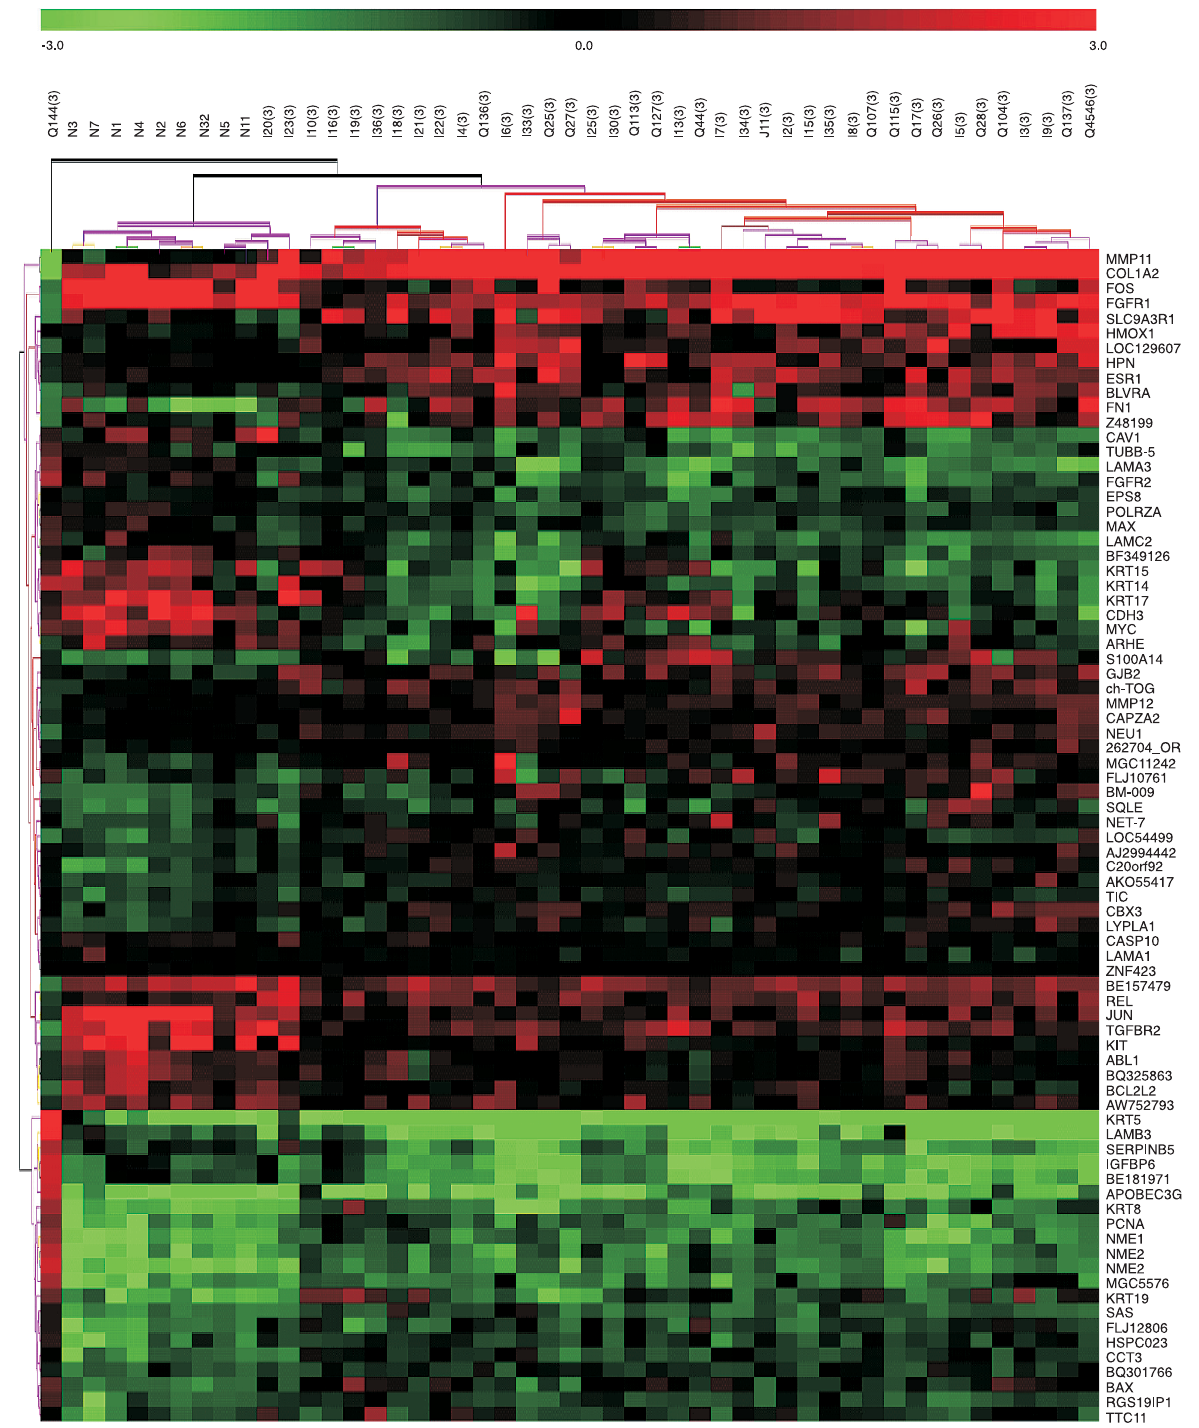
Figure 2. Unsupervised hierarchical clustering of 40 clinical stage III breast cancer tumors and 9 normal breast samples (N) based on 78 differentially expressed genes at a false discovery ratio level of 0.05. Tumor and gene identification, upper colored bar, and colored lines of the dendrogram, as described in Figure